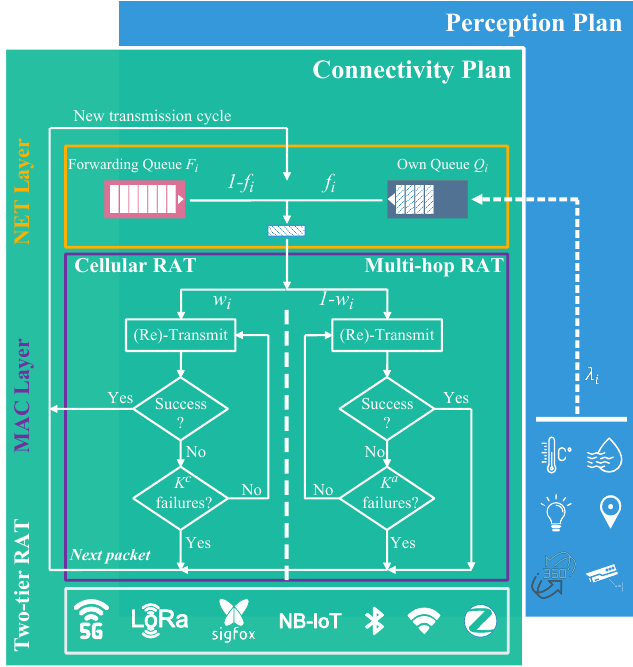
Figure 3. Two-tier IoT network packet transmission cycle and cross-layer flow